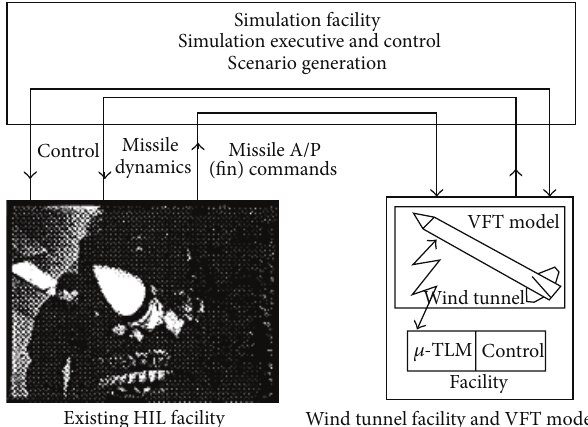
Figure 10: For the wind tunnel free-flying test, the aircraft model is remotely controlled or uncontrolled. It flies unconstrainedly in the tunnel test section, which can avoid the interference of model support rigs. The only aerodynamic interference comes from the safety cable (if added). Free-flying test methods include free-flight [26–39], free spin [40], free tumble [41], and free fall [7]. A VFT architecture proposed by Standard Missile Company [85].